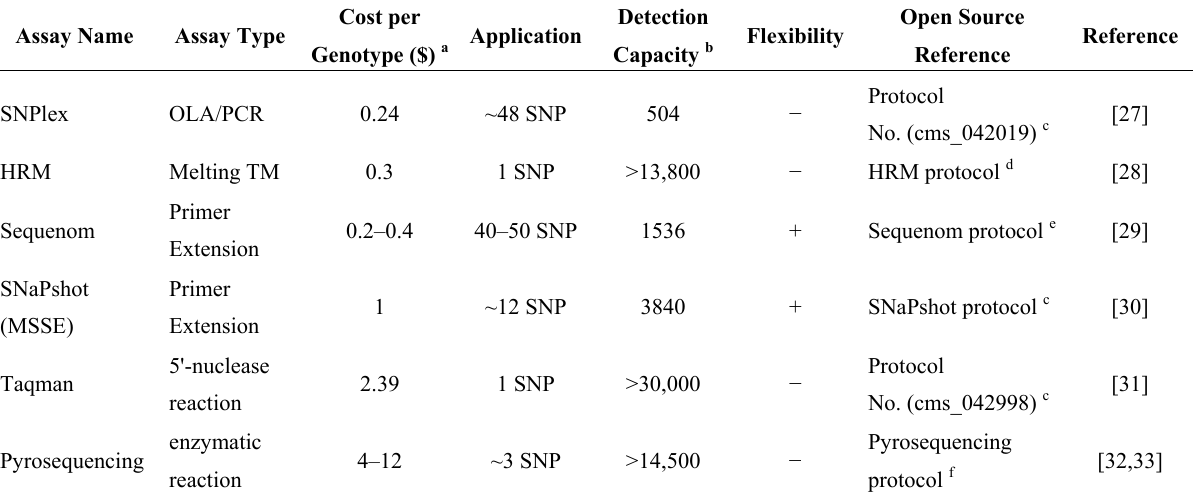
( B ) Table 4. Comparative analysis of commonly used genotype